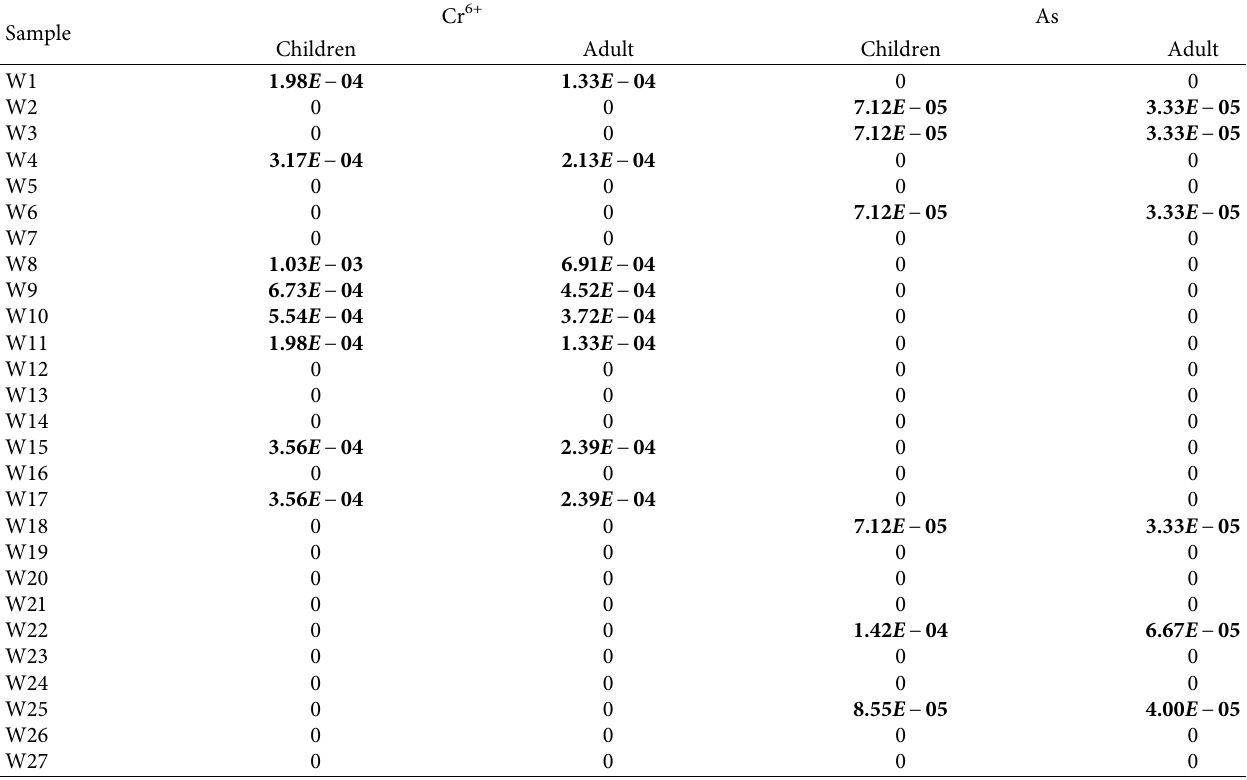
Table 6: Carcinogenic risk of Cr 6+ and As in all the